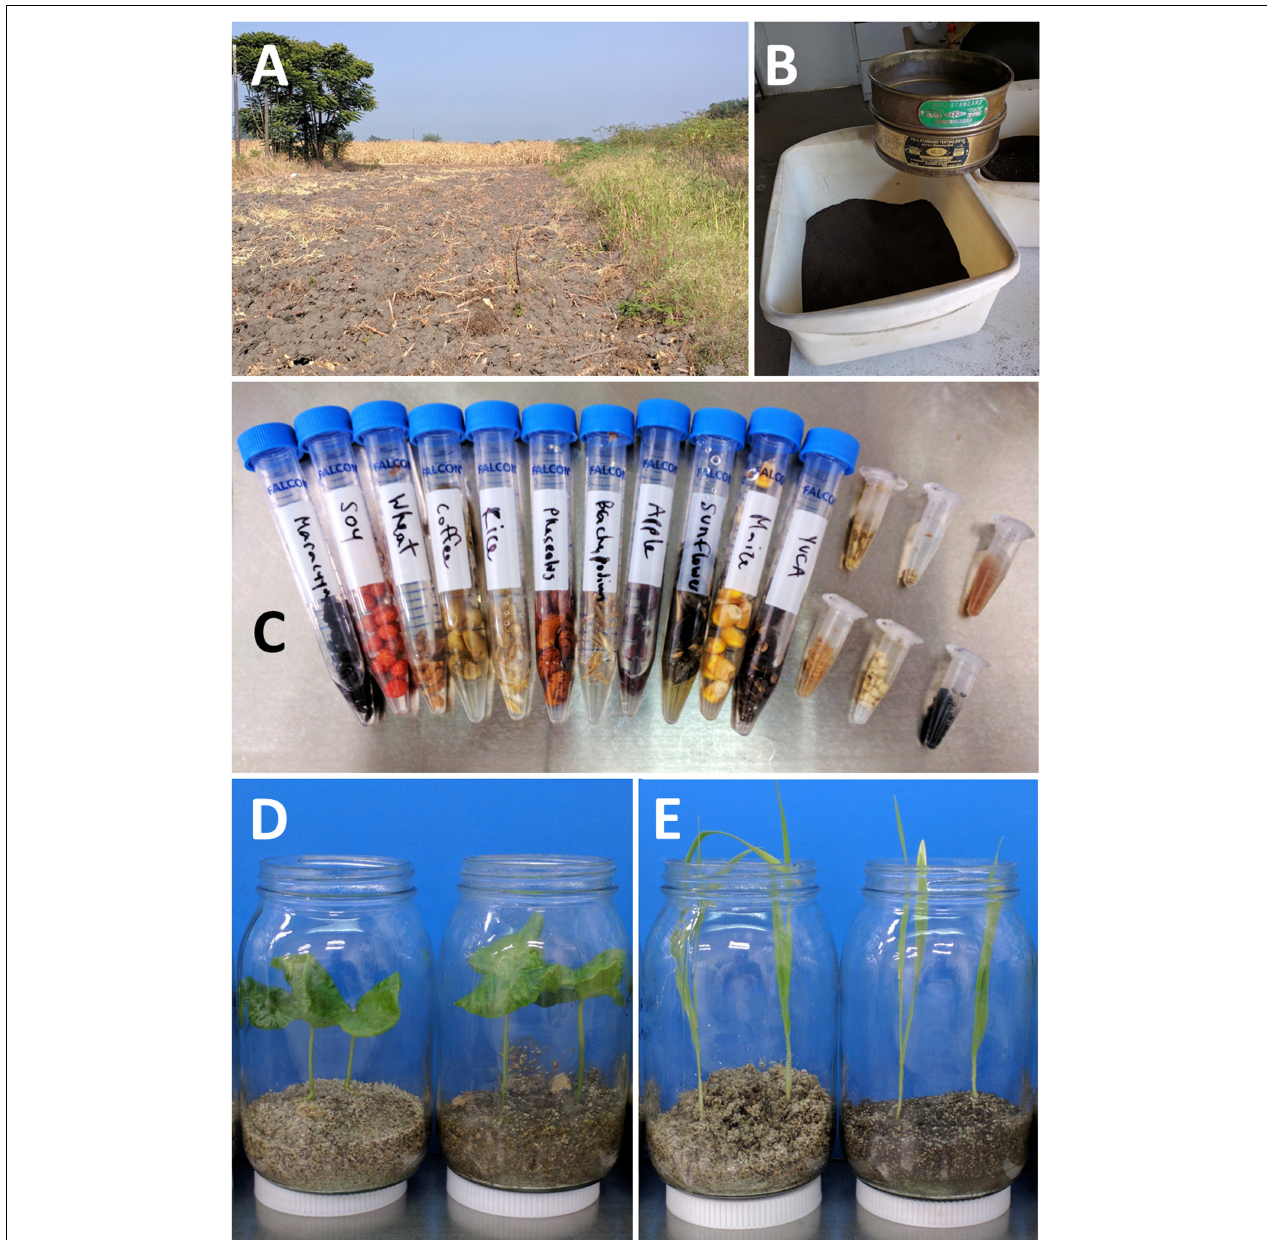
FIGURE 1 | Soil, seeds, and examples of the gnotobiotic terrariums used to grow plants in this study. (A) Fallow cassava field at CIAT where soil was harvested. (B) Cassava field soil after sieving. (C) Soaking in sterile water prior to extraction of seed endosphere and spermosphere DNA (yucca = cassava; maracuya and apple were later replaced with pea and barley). (D) Coffee at harvest after growth in sterile sand on the left and field soil mixed with sand on the right. (E) Barley at harvest after growth in sterile sand on the left and field soil mixed with sand on the